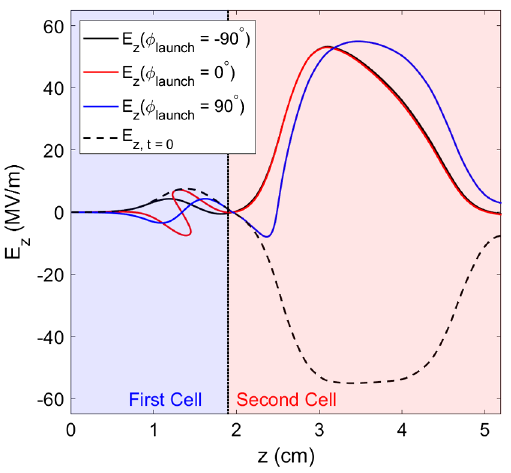
FIG. 5. 1D code coarse scan results around highest capture and highest KE . ave